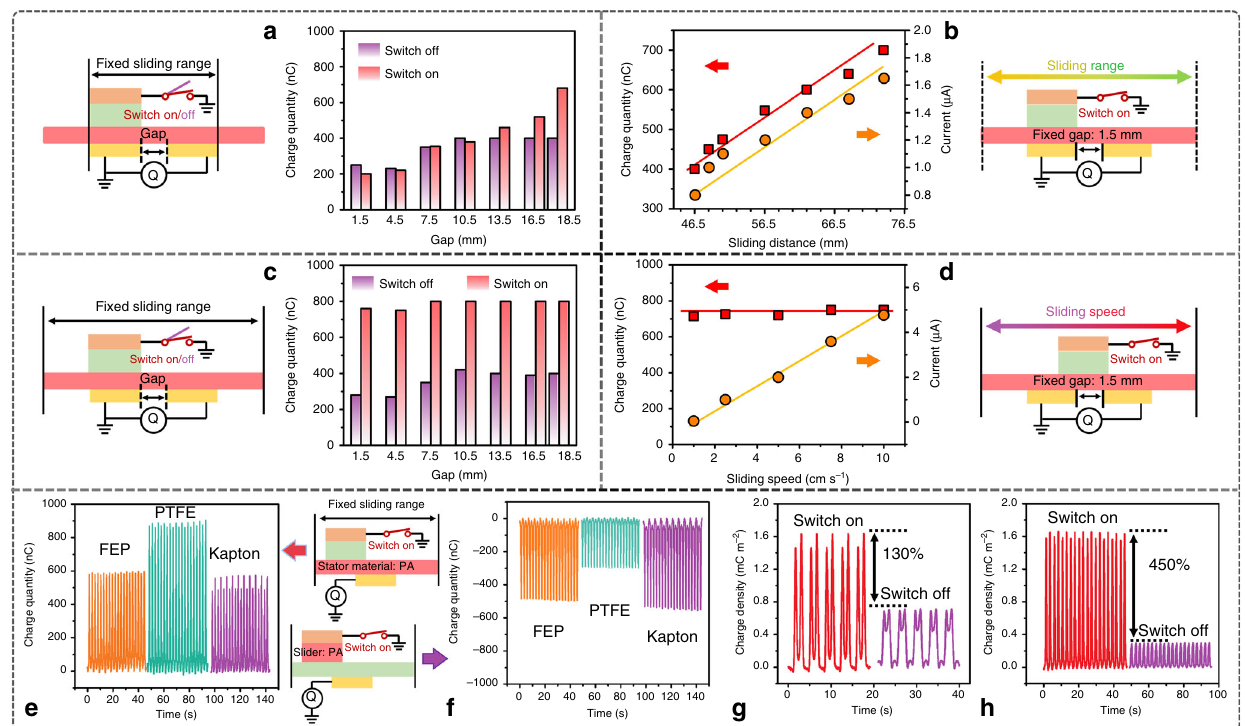
Fig. 2 Structure and materials ’ in fl uence on the output of CSA-S-TENG. a Output charge of double-bottom-electrode S-TENG with different inner electrode gaps when grounded switch is OFF/ON. b Output charge and current of CSA-S-TENG with fi xed electrode gap while varying sliding range (speed fi xed at 4 cm s − 1 ). c Transferred charge of CSA-S-TENG with different inner electrode gaps when grounded switch is OFF/ON. d Output charge and current of CSA-S-TENG with fi xed bottom electrode gap while varying sliding speed (range fi xed at 76.5 mm). e , f Output charge of single electrode CSA- S-TENG with fi xed stationary material PA while varying sliding materials (FEP, PTFE and Kapton) and fi xed sliding material PA while varying stationary materials (FEP, PTFE and Kapton), respectively. Optimized output charge density of g double electrode and h single electrode CSA-S-TENG with grounded switch extending from 46.5 to 76.5 mm, the output charge and current of CSA-S-TENG increase from 400 nC, 0.8 μ A to 700 nC, 1.6 μ A linearly, and the optimized ratio for maximum performance is